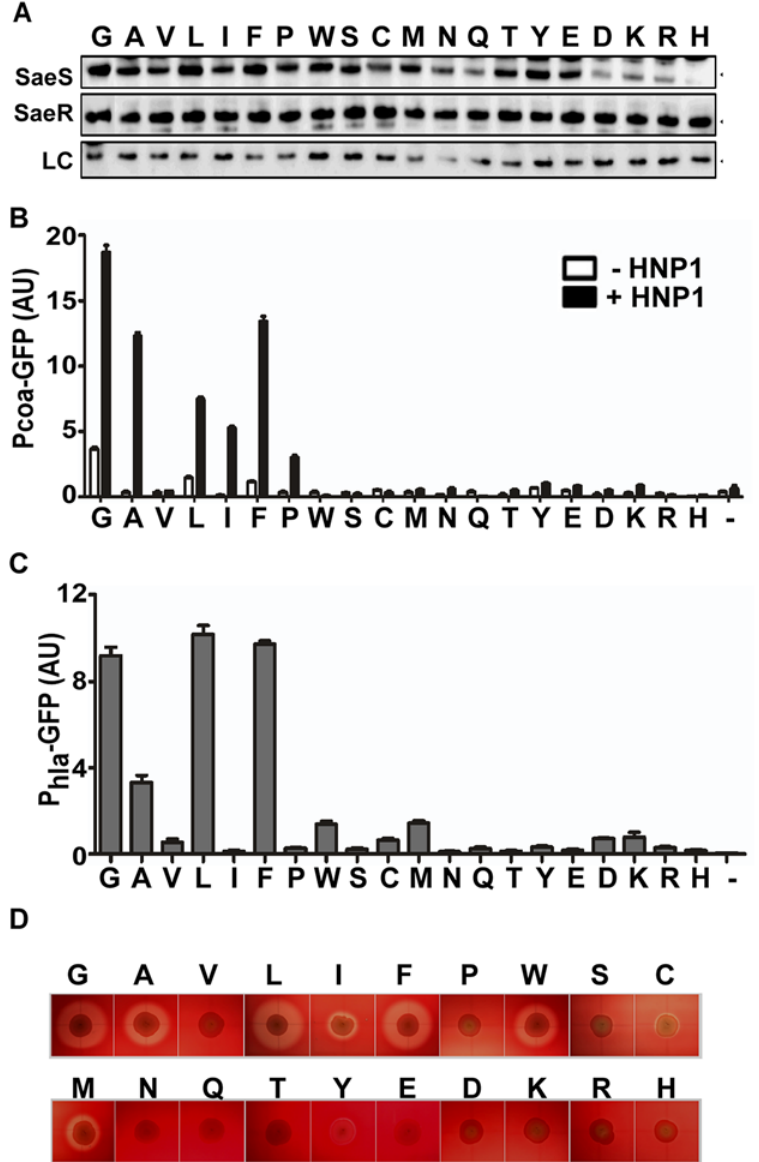
Fig 7. At the position 35, Gly is the optimal amino acid for SaeS switch function. (A) Expression of the substitution mutants of SaeS analyzed by Western blot. Amino acid at position 35 is shown at the top of the panel. An equal number of the cells were harvested at exponential growth phase and used for the analysis. LC, loading control. (B) GFP transcription from the low affinity target P coa in strains carrying wild type or mutants of SaeS carrying various amino acid substitutions at the position 35. Experiment conditions are the same as in Fig 2C. HNP1 (5 μ g/ml) was used to induce the SaeRS TCS. Error bars represent the standard error of the mean.-, vector control; AU, arbitrary unit. (C) GFP transcription from the high affinity target P hla . The error bars indicate the standard error of the mean.-, vector control. (D) The effect of the substitution mutations on the hemolysis activity of S . aureus . The test strains were grown on a rabbit blood agar